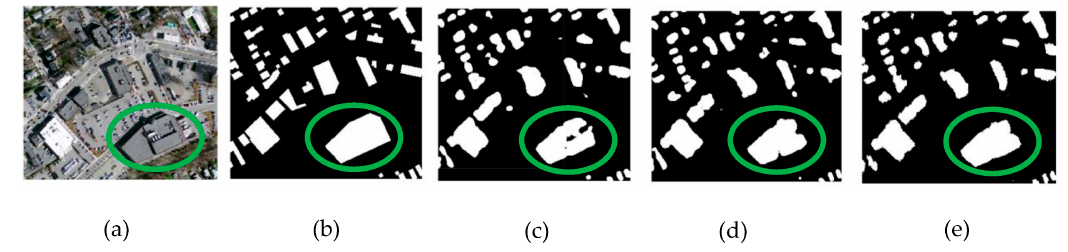
Figure 6. Visual comparison of three variations of the proposed techniques on large buildings using sample aerial test images of the Massachusetts area. ( a ) original input image; ( b ) ground-truth map; ( c ) output of FCN-8s; ( d ) output of ELU-FCN; and ( e ) output of ELU-FCN-CRF.